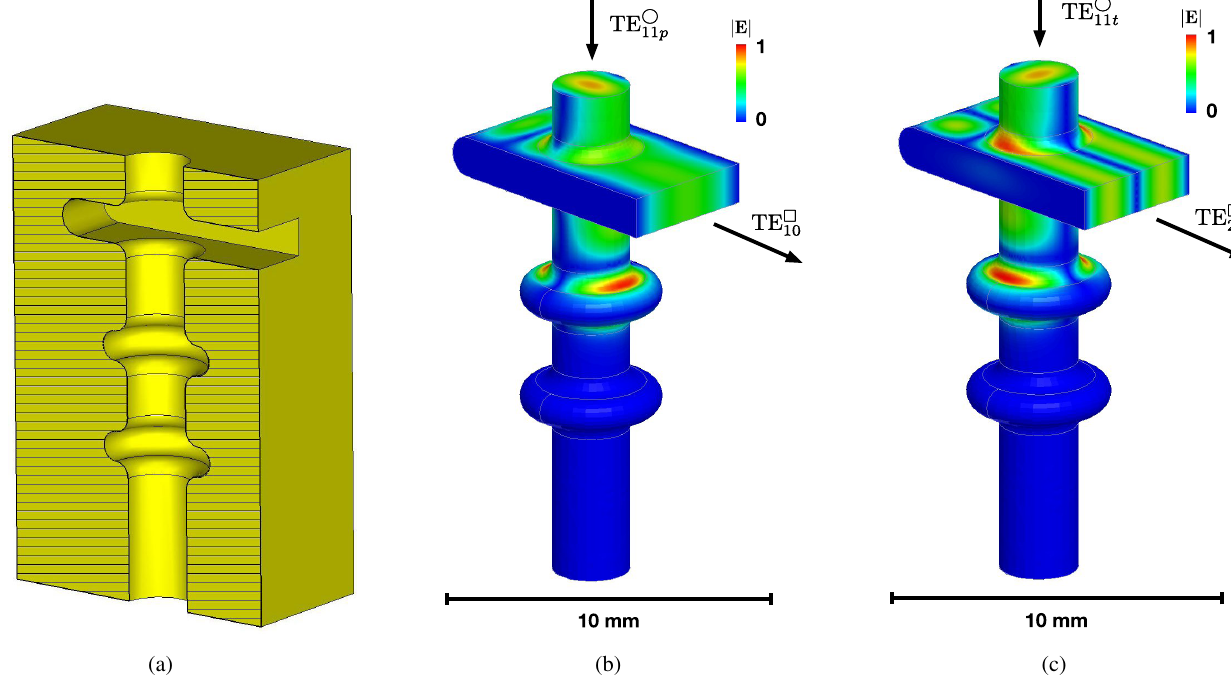
FIG. 23. TE ○ 11 to rectangular TE □ 10 = TE □ 20 mode converter with chokes. (a) Metallic surface, (b) surface electric field for the parallel polarization, and (c) surface electric field for the transverse